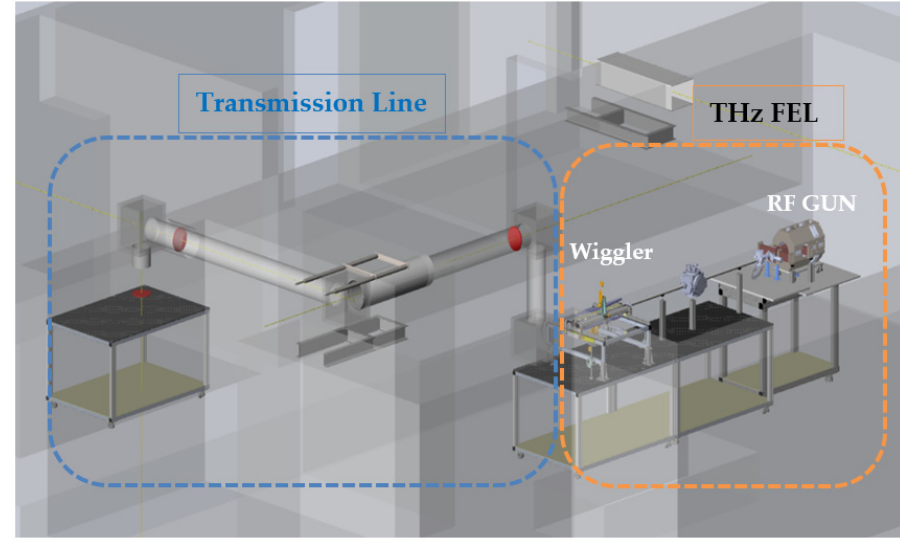
Figure 1. THz FEL setup at the Schlesinger Center.